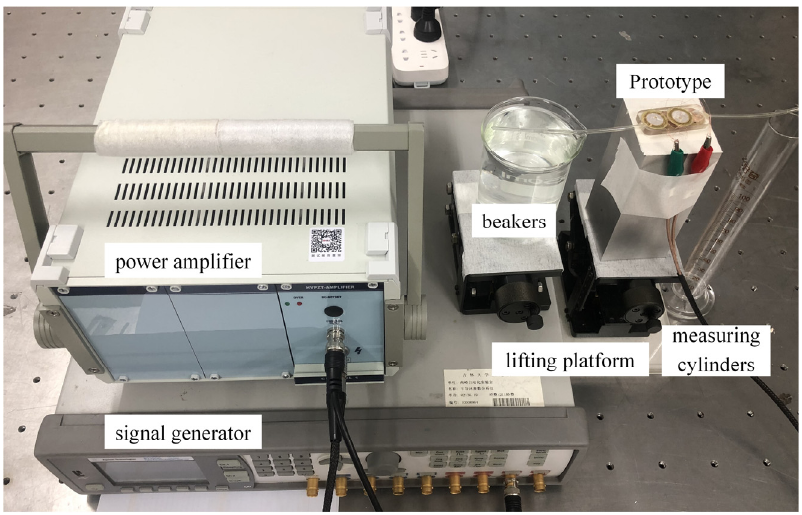
Figure 5. Photograph of the experimental device.